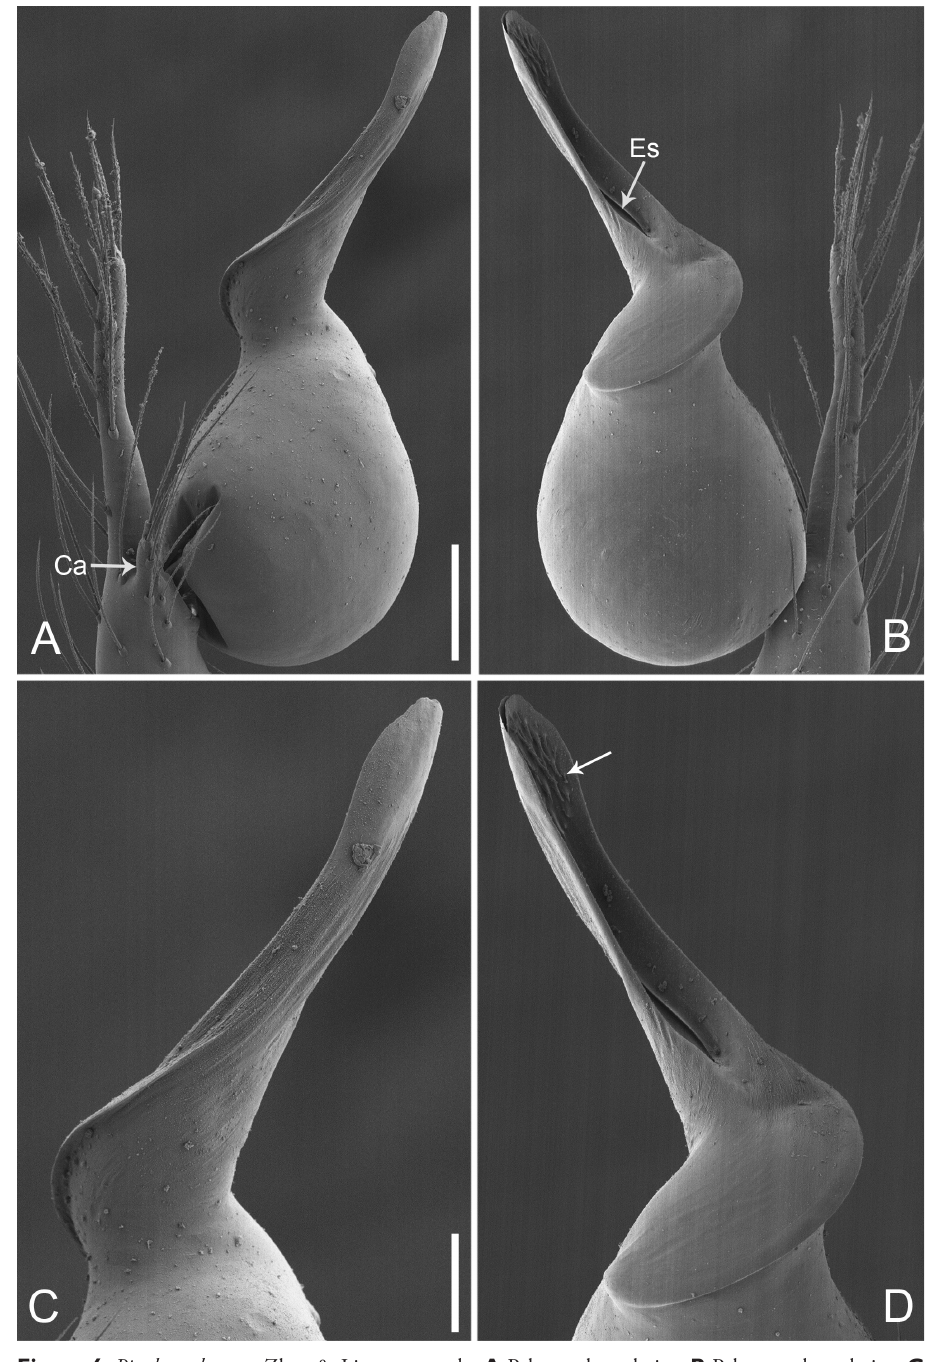
Figure 6. Pinelema huoyan Zhao & Li, sp. n., male. A Palp, prolateral view B Palp, retrolateral view C Embolus, prolateral view D Embolus, retrolateral view. Scale bars: 0.1 mm ( A–B ), 0.05 mm ( C–D